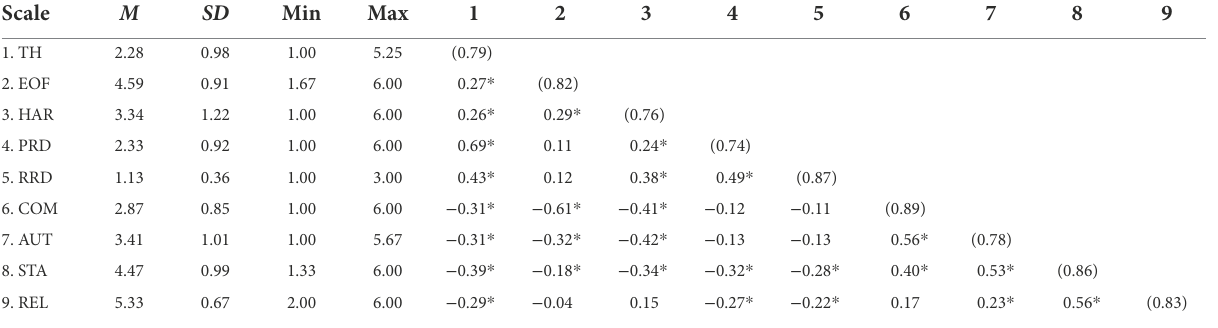
TABLE 1 Descriptive statistics and correlations of threat, triggers, and needs after CAS (action phase 2).